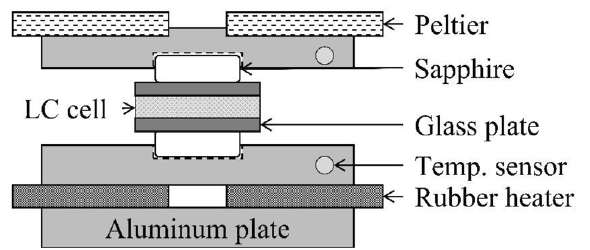
Figure 8. A schematic image of our constructed temperature controller. The LC cell is sandwiched between sapphire glass. The temperatures of the upper and lower aluminum plates are independently controlled by a Peltier element and a rubber heater,